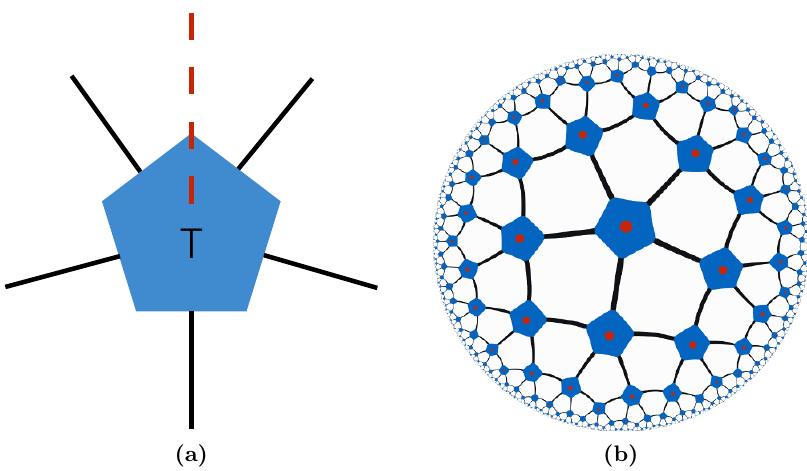
Figure 1. (a) The fundamental tensor T of the pentagon code showing the bulk leg (dashed line, red in color version) and the network legs (solid lines). (b) These units are contracted along their networks legs to form a pentagonal tiling of the hyperbolic